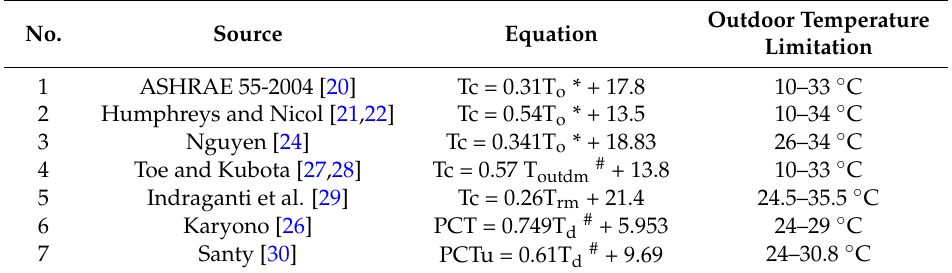
Table 3. Several adaptive comfort model in the literature. PCT, Predictive Comfort Temperature.